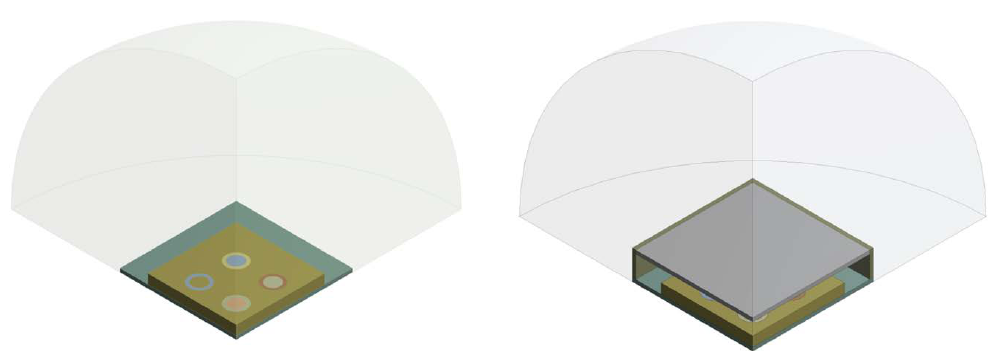
Figure 10. Analyzed limit situations: stand-alone device ( left ), packaged device ( right ).